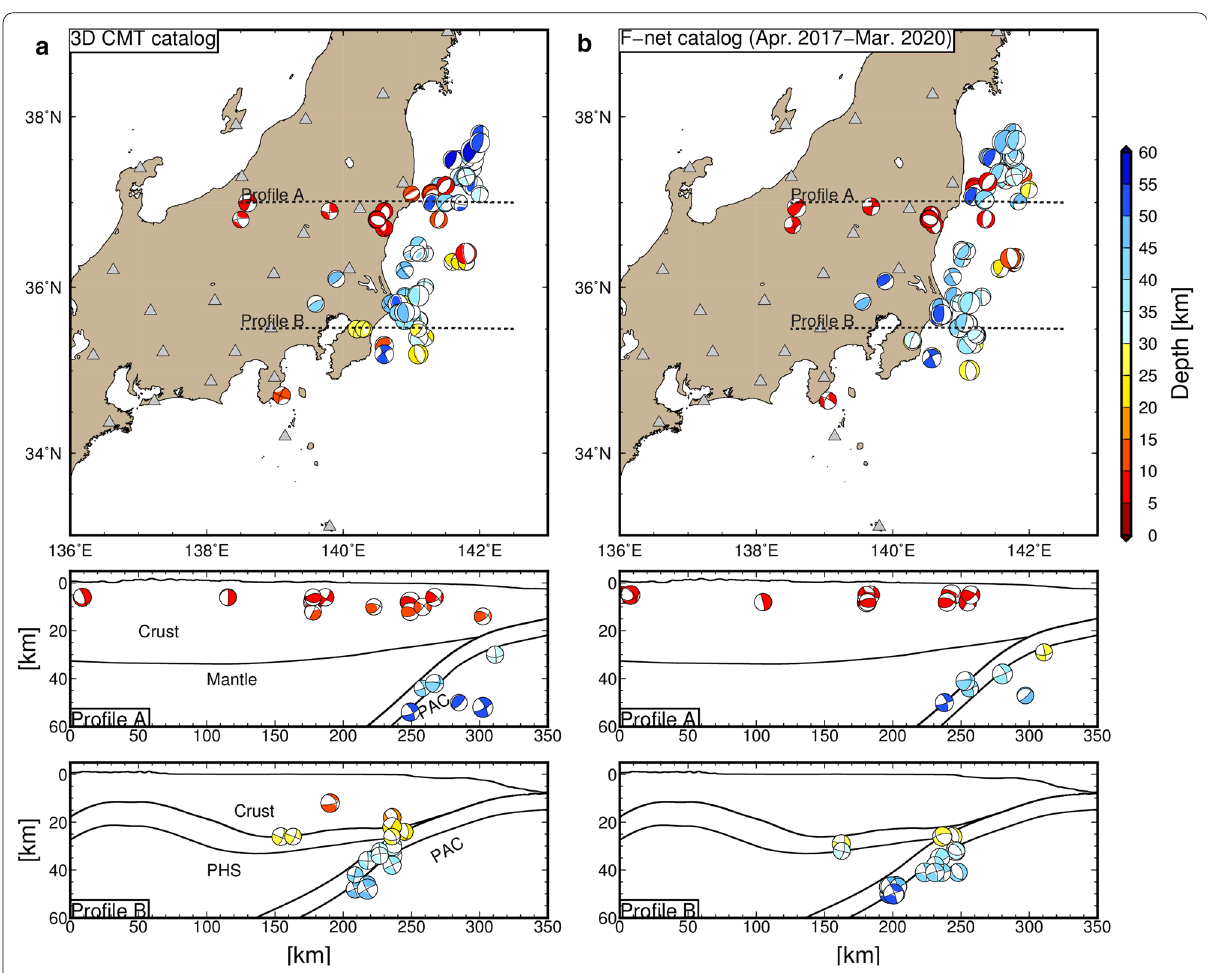
Fig. 3 Results of 3D CMT inversion in the Kanto region. a 3D CMT catalog (this study), and b F-net MT catalog. Upper panels are map views of focal mechanisms. The colors represent the estimated centroid depth. The bottom panels show cross-sections along profiles A and B. In the bottom panels, topography, Moho, the upper surface of subducting plates, and the oceanic Moho are